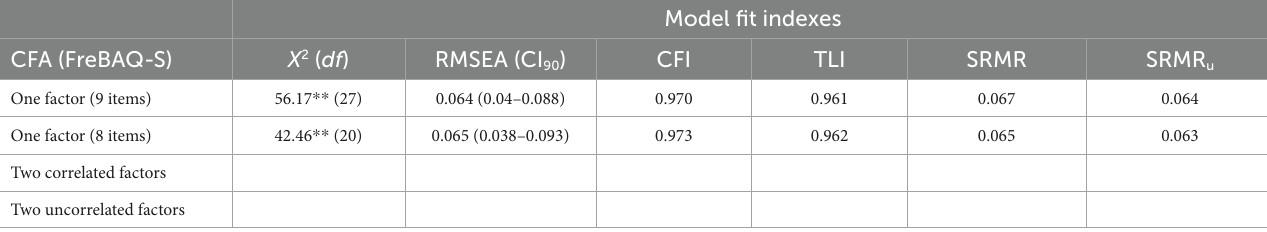
TABLE 2 Confirmatory factor analysis fit indexes.